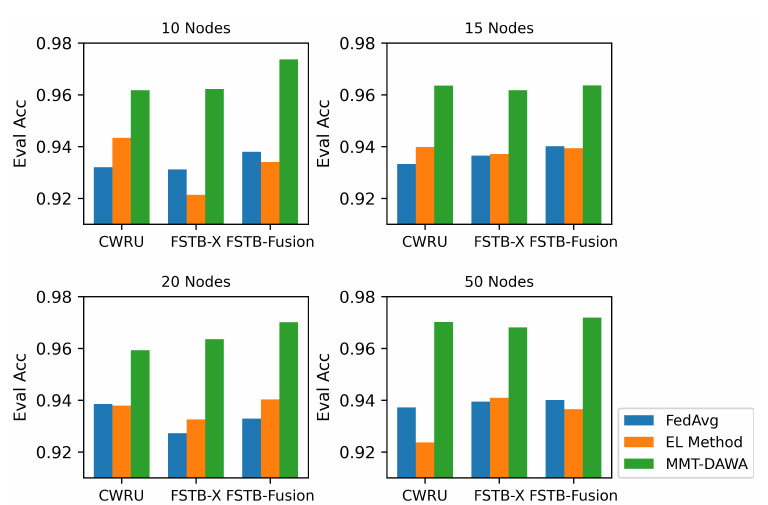
Figure 14. Evaluating accuracy comparison among federated average (FedAvg), ensemble learning voting (EL Method), and multi-model transfer and dynamic adaptive weight adjustment (MMT- DAWA) with node numbers varying among 10, 15, 20, and 50.